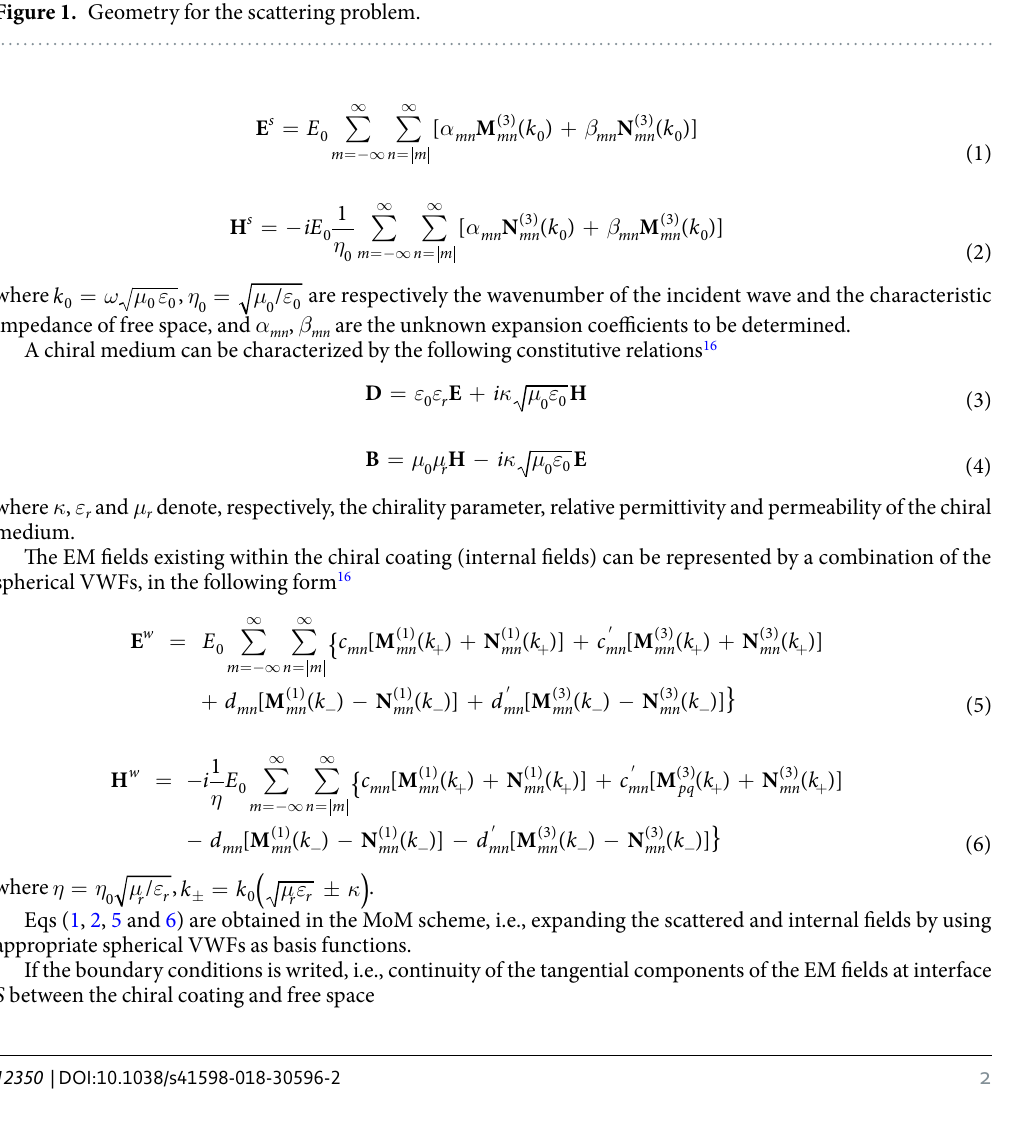
Figure 1. Geometry for the scattering